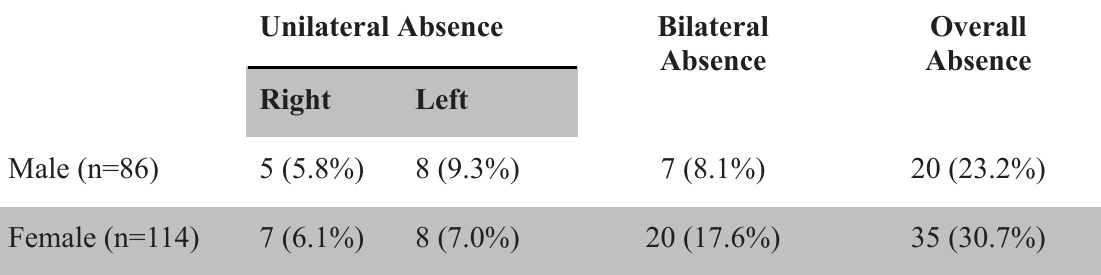
Table 2: Prevalence of absence of palmarislonguson the basis of gender